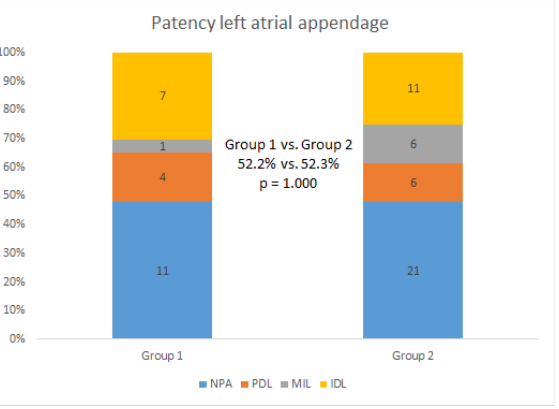
Figure 3. Follow ‐ up results in patients who received cardiac computed tomography angiography. Figure 3. Follow-up results in patients who received cardiac computed tomography angiography. NPA = no patency left atrial appendage; PDL = peri ‐ device leak; MIL = mixed leak; IDL = intra ‐ NPA = no patency left atrial appendage; PDL = peri-device leak; MIL = mixed leak; IDL = intra-device device leak.